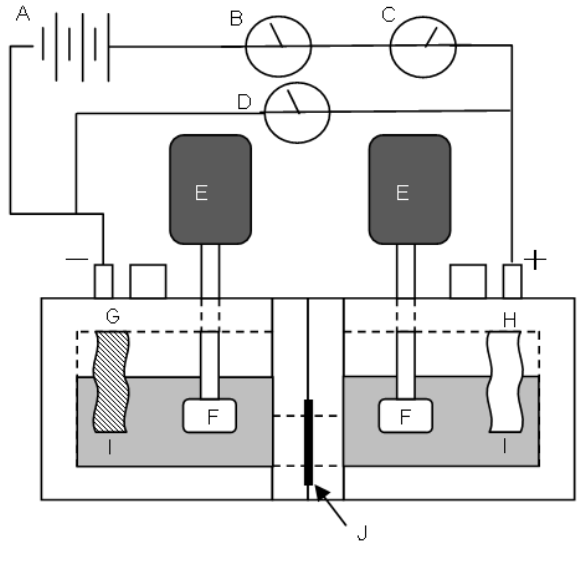
Figure 10. Apparatus for measuring the dynamic state transport number. A: power supply; B: ampere meter; C: coulomb meter; D: voltmeter; E: motor; F: stirrer; G: cathode electrode; H: anode electrode; I: 0.5 mol/dm 3 NaCl solution; J: sample membrane. The effective area of the cell is 8.0 cm 2